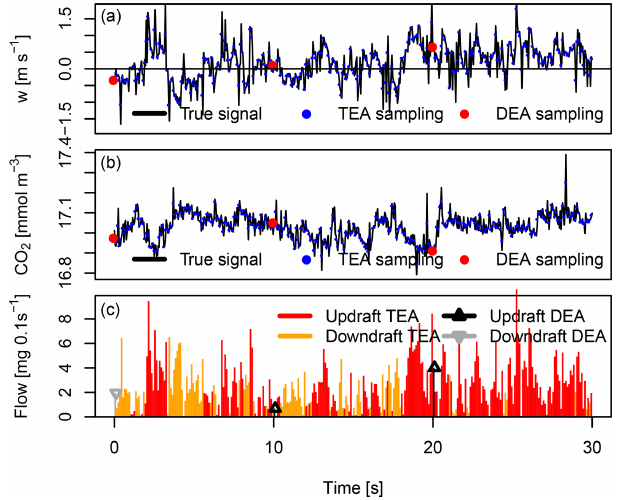
Figure 1. True eddy accumulation (TEA; see Sect. 1.1.1) and dis- junct eddy accumulation (DEA; see Sect. 1.1.3) sampling scheme. Vertical wind, w , (a) , scalar density, CO 2 , (b) and vertical wind pro- portional mass flow rate (c) . Black solid lines indicate the continu- ous true atmospheric signal. Sampling resolution of TEA and DEA are 10Hz and 10s, respectively. Note that active sampling time for DEA is only 1% of the sampling time for